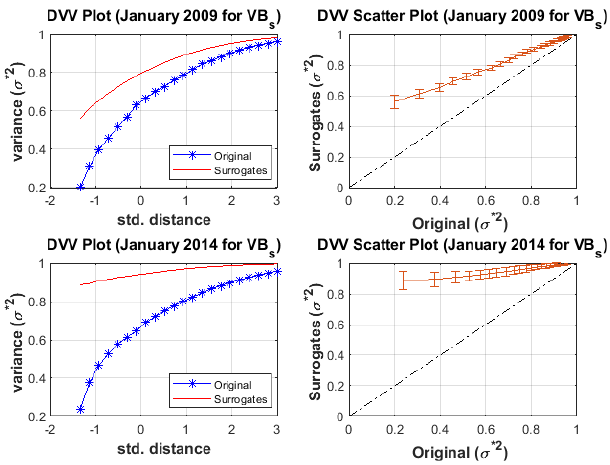
Figure 10. The DVV plot and scatter plot for VB s during minor geomagnetic storm for January 2009 and January